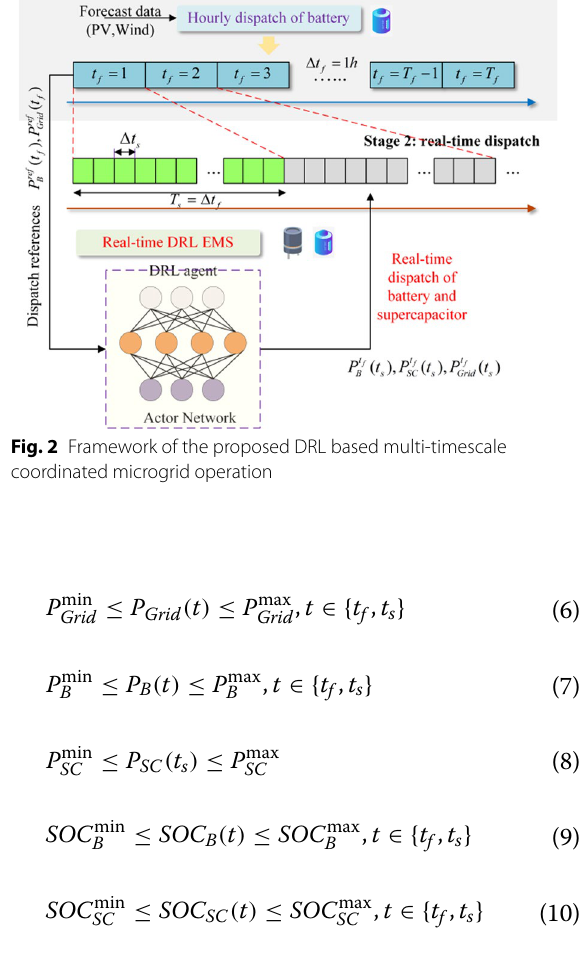
Equation (6) is the power limit constraint of buying/ selling electricity from/to utility grid, while (7), (8) are the charging or discharging power limits of the battery and supercapacitor, respectively. Equations (9), (10) are the state of charge (SOC) limits required to avoid the battery and supercapacitor over-charging or over-dis- charging, respectively.